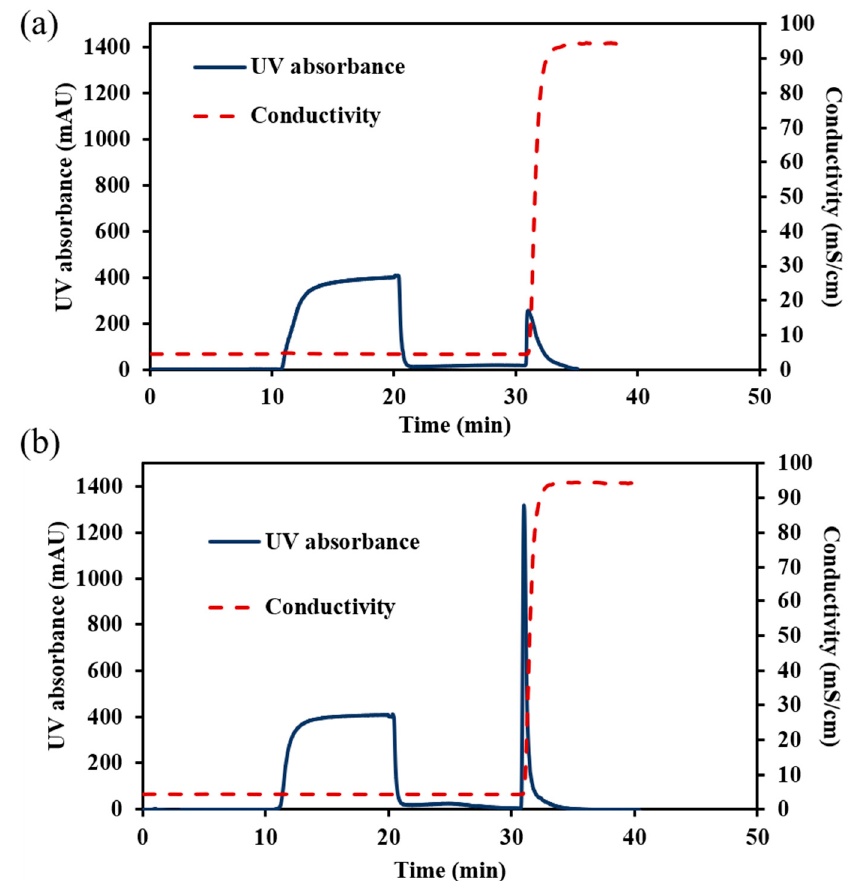
Figure 7. The PSf-GMA-DEA membrane was surface modified with 7 min of UV polymerization whereas the PAN-GMA-DEA membrane was modified with 15 min of UV polymerization. The PSf-GMA-DEA membrane exhibited a BSA protein binding capacity of 201.3 mg / mL membrane volume as compared to the value of 87.2 mg / mL for the corresponding PAN-GMA-DEA membrane. However, in the case of PSf-GMA-DEA membrane, only ~56% of the BSA was recovered upon elution which was significantly lower than the value of ~96% for the corresponding PAN-GMA-DEA membrane. The protein binding and recovery results are tabulated in Table 1. The fact that PSf-GMA-DEA has a much higher protein binding capacity and relatively lower protein recovery and that PAN-GMA-DEA has a lower protein binding capacity and a much higher recovery agrees with the properties of the membranes and our previous static protein binding tests. The former is more hydrophobic and thus more non-specific hydrophobic and thus more non-specific protein binding leading to a higher binding capacity but protein binding leading to a higher binding capacity but lower recovery. The latter is more hydrophilic with much less non-specific protein binding leading to a lower binding capacity but increased recovery. to a lower binding capacity but increased recovery.